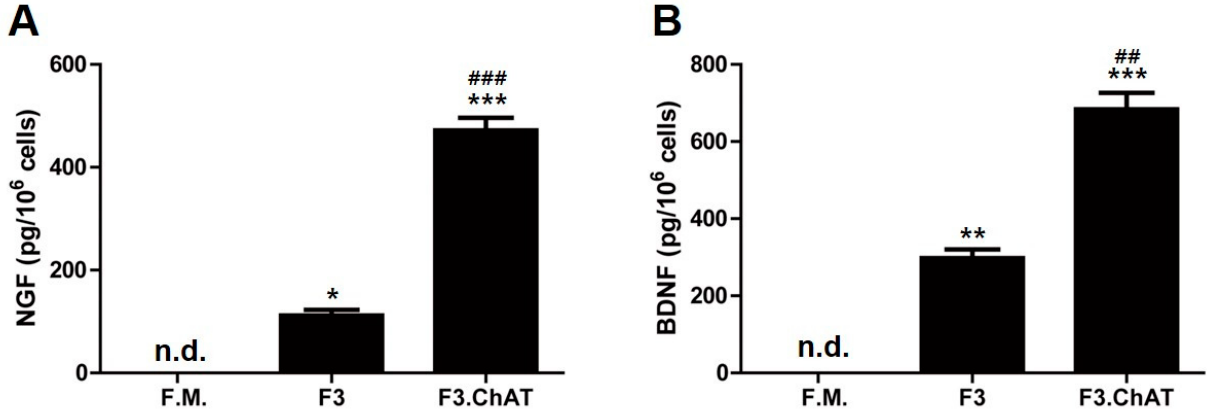
Figure 3. Concentration of NGF ( A ) and BDNF ( B ) in F3 and F3.ChAT cells cultured in conditioned medium. The levels of NGF and BDNF were analyzed using an ELISA kit. The experiments were performed in triplicate, and mean values are presented. F.M.; Fresh mediumm, n.d.; not detected. * Significantly different from the fresh medium ( p < 0.05). ** Significantly different from the fresh medium ( p < 0.005). *** Significantly different from the fresh medium ( p < 0.001). ## Significantly different from the F3 ( p < 0.005). ### Significantly different from the F3 ( p < 0.001).